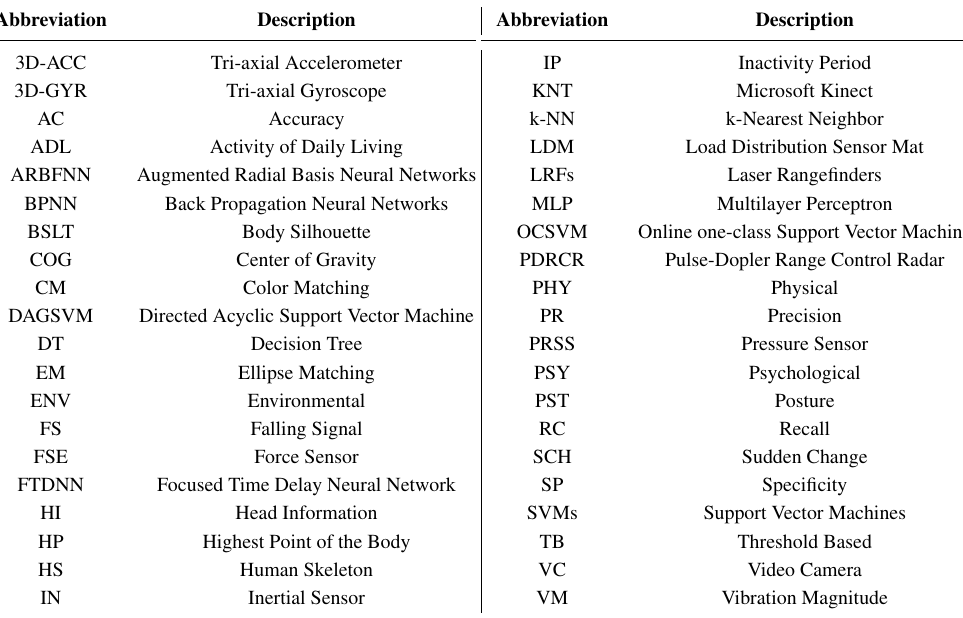
Table 3. List of Abbreviations and